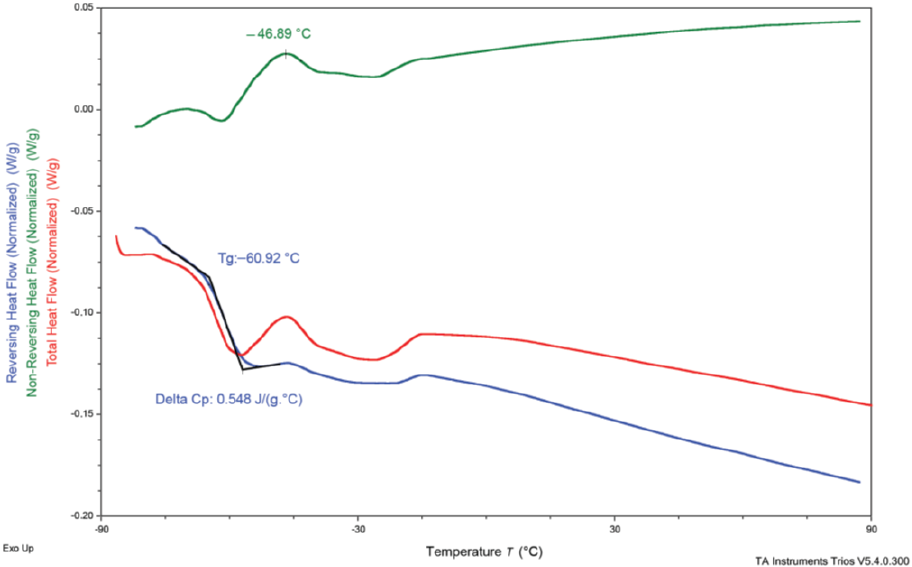
Figure 5. DSC thermogram of the neat formulation.